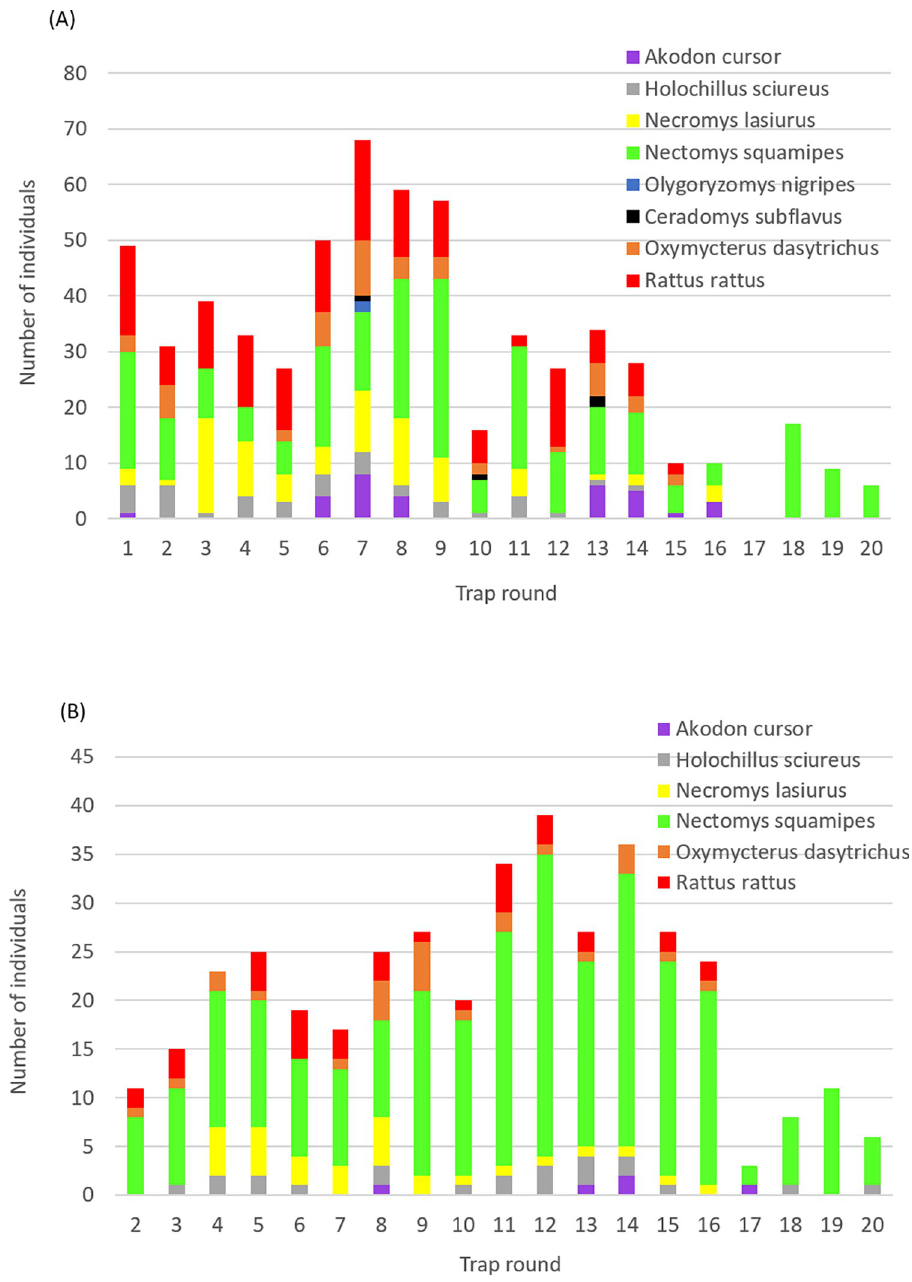
Fig 1. Number of rodents captured in each trapping round (A) individuals at first capture; (B) all individuals recaptured. which was more frequent than the other species, each being recaptured up to 4 times (S4A and S4B Fig). R . rattus was recaptured on relatively fewer occasions and showed a greater affinity to peri domestic and plantation environments (S4D Fig), and was the only species captured in all three sampled habitat types (Table 1). The abundance and affinity with a particular habitat varied between rodent species, however the proportion of total (re)capture events was gener- ally highest in plantations when adjusted for trapping effort (Table 1 and S4C and S4D Fig).